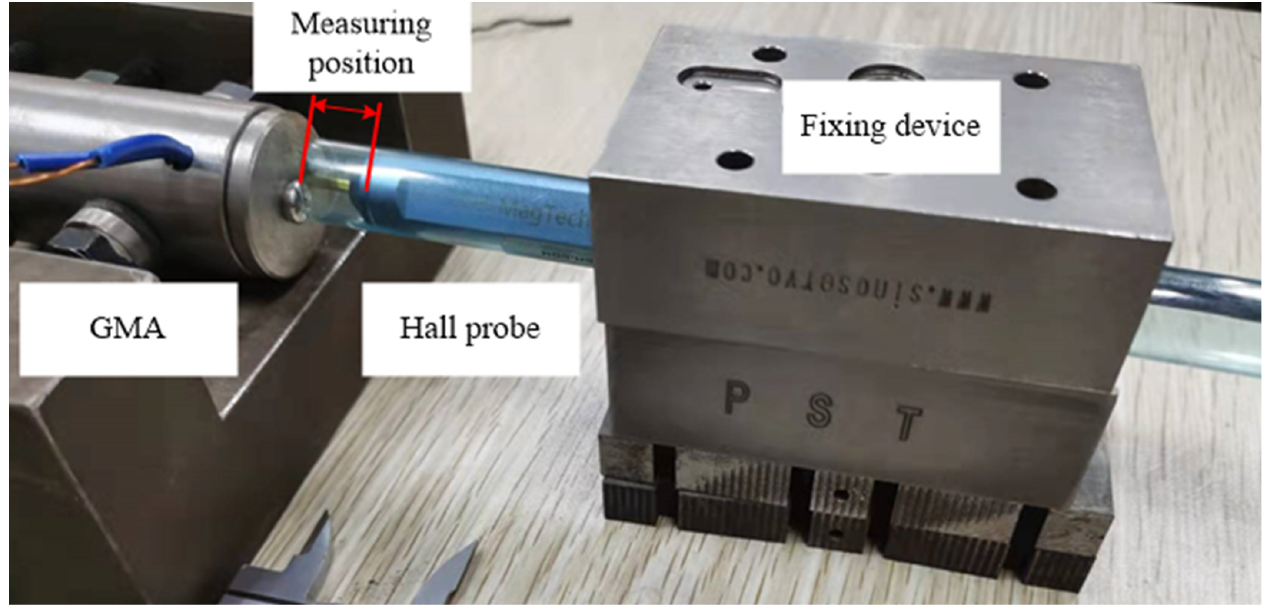
Figure 22. Schematic diagram of experiment